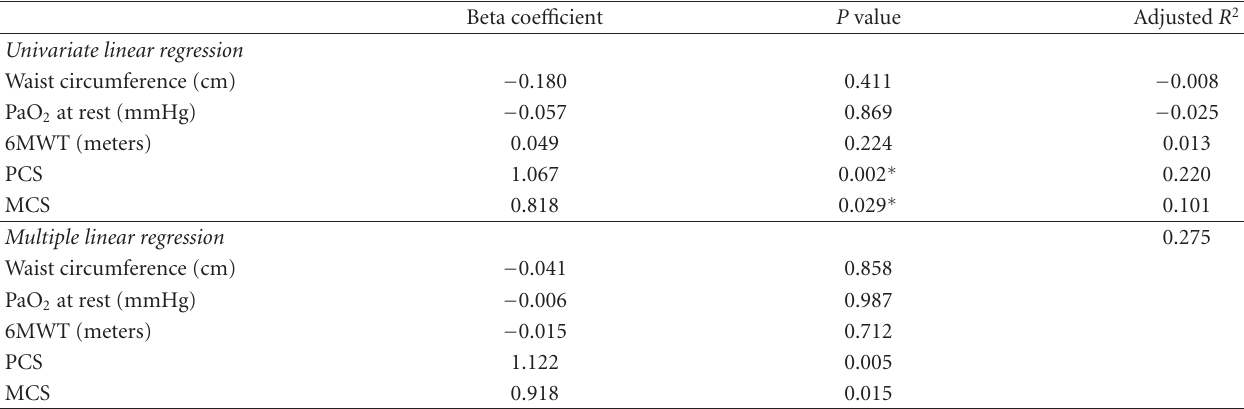
Table 5: Univariate and multiple linear regression models to predict